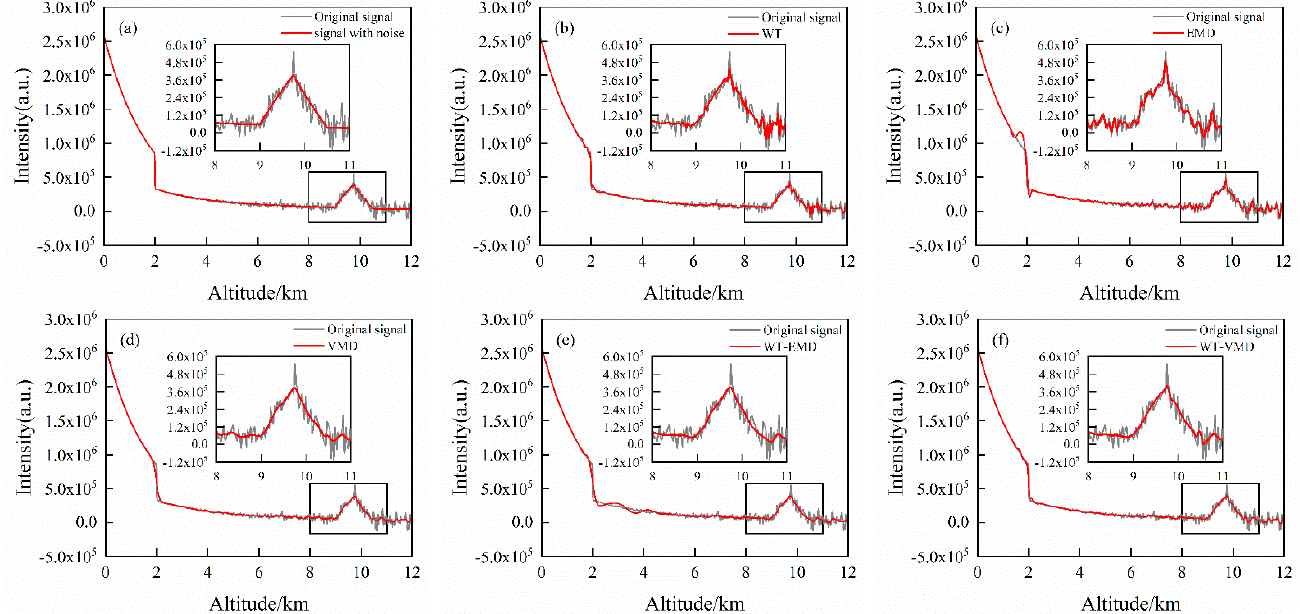
Figure 8. Experimental results of denoising of 1000-pulse cumulative simulation signals (with aerosol